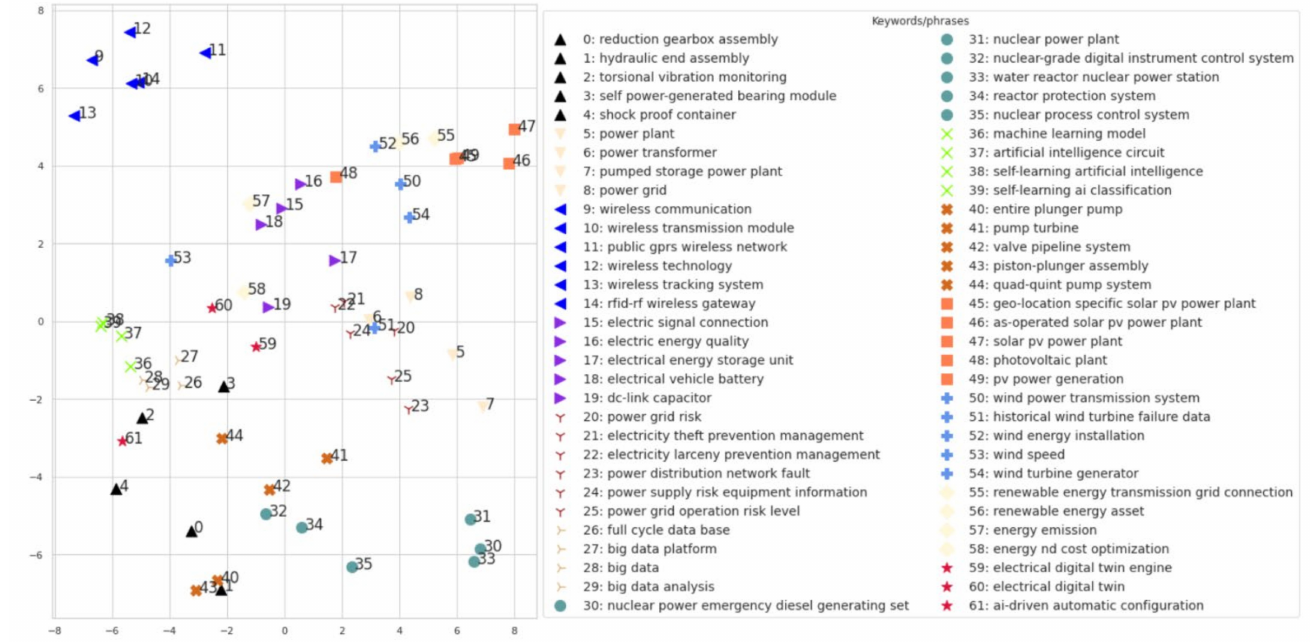
Figure 13. Visualization of 13 phrase clusters extracted from retrieved